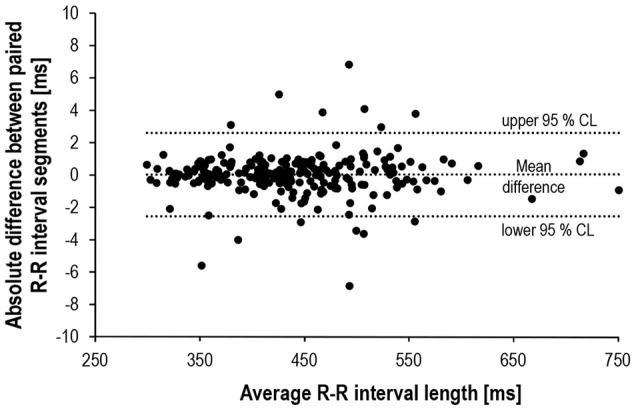
Bland-Altman plot of the absolute R-R differences (N = 245) between matched pairs (PRE vs. POST).